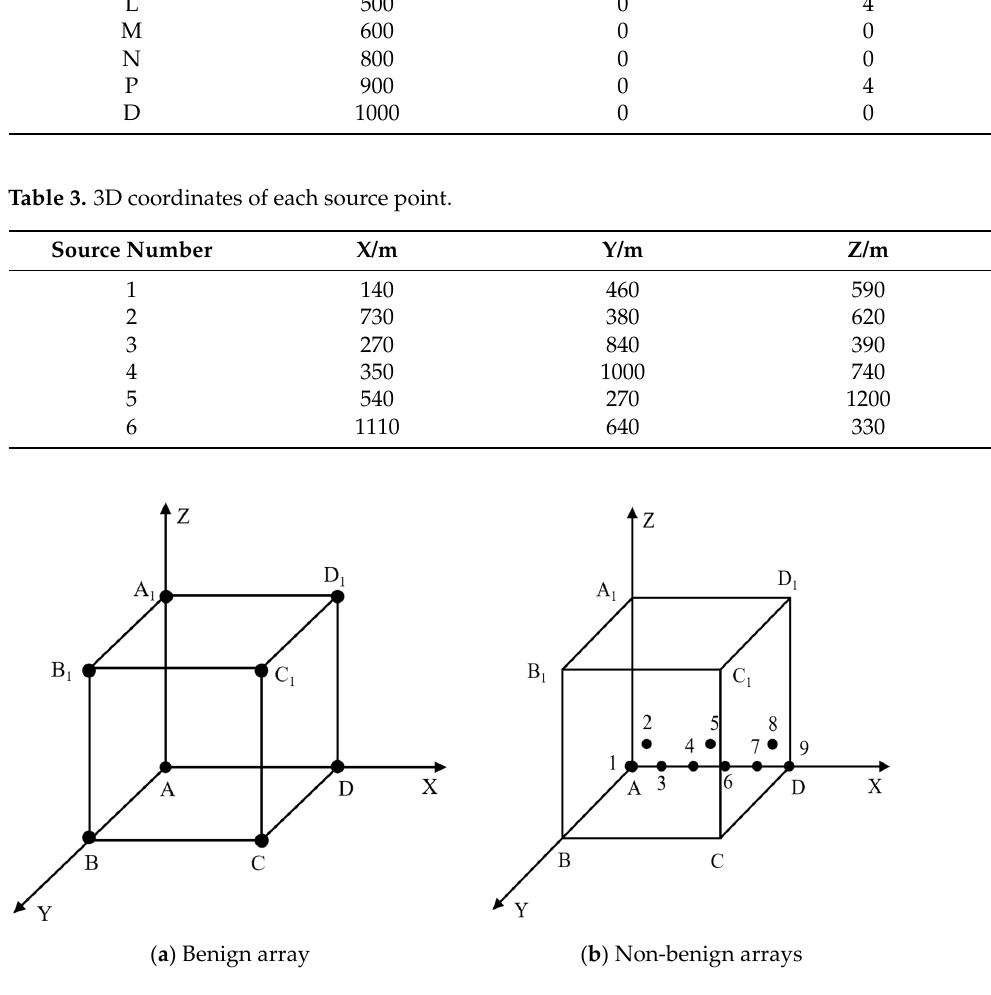
Table 2. 3D coordinates of non-benign array detectors.